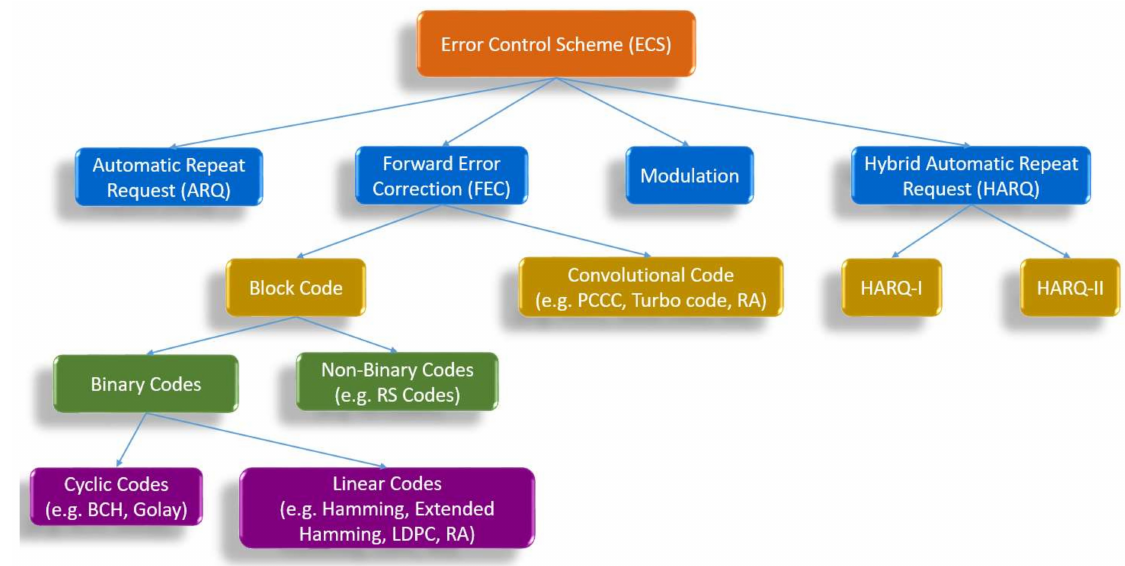
Figure 1. Classification of Error Correction Schemes (ECS) for wireless body area networks (WBAN) error correction